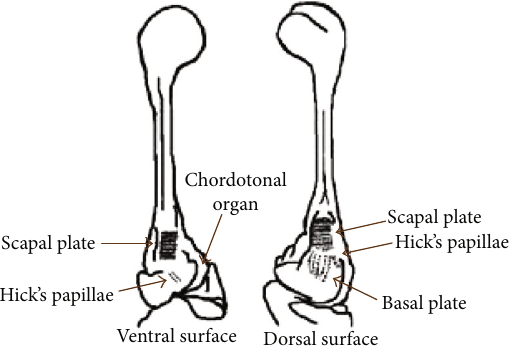
Figure 4: Sensilla classi fi cation as per Pringle